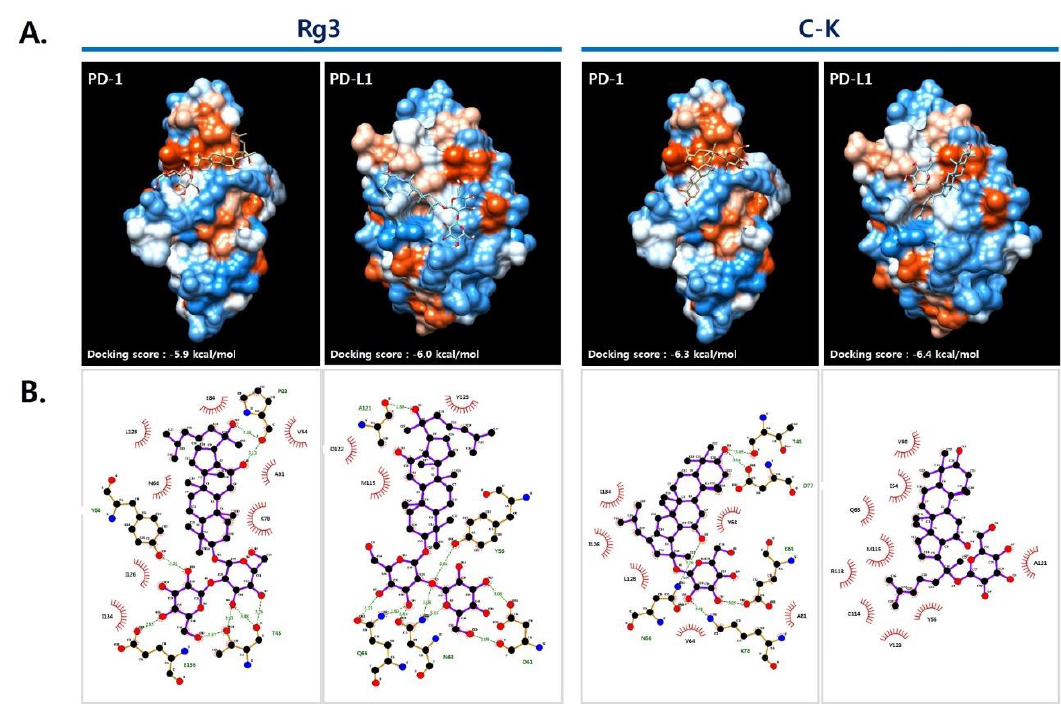
Figure 3. Protein–ligand docking simulation between PD-L1 / PD-1 and Rg3 / C-K. ( A ) Rg3 and C-K were docked into PD-1 and PD-L1 derived from the PD-1 / PD-L1 complex (PDB code: 4ZQK) using AutoDock Vina. ( B ) The amino acids involved in hydrogen bonds and hydrophobic interactions between PD-L1 / PD-1 and ginsenosides were presented via analysis using LigPlot + v.1.4.5 (EMBL-EBI, Cambridge, UK). The amino acid residues involved in the interactions were indicated with black (hydrophobic interactions) and green (H-bonds).